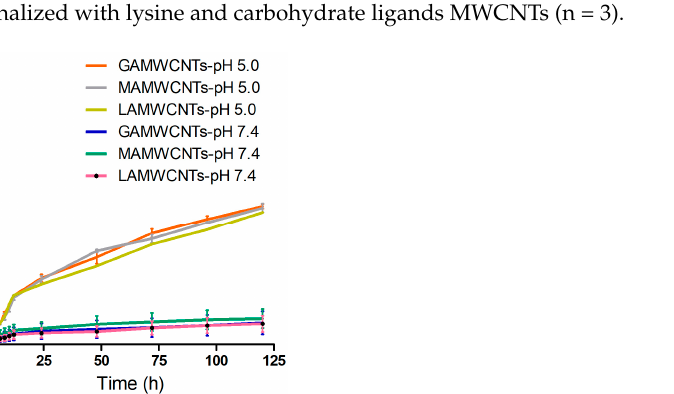
functionalized with lysine and carbohydrate ligands MWCNTs (n = 3).